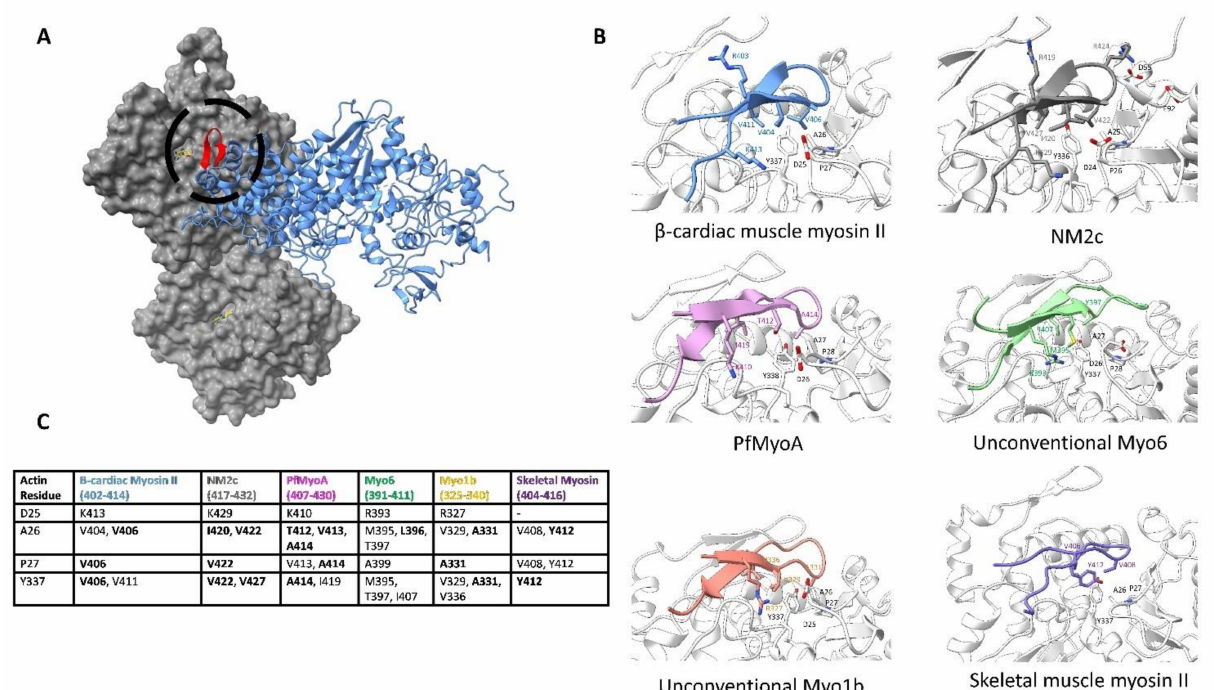
Figure 6. F-actin subdomain 1 binds to the CM loop. ( A ). The overall positioning of the actin surface relative to the CM loop. The motor domain is in blue while the CM loop is colored in red and circled; actin is in gray. ( B ). The residue-level binding interface between actin subdomain 1 and the myosin CM loop from the six myosin structures is indicated in Supplementary Item Table S2. Actin backbone and residues are colored white, while myosin residues are colored by isoform. Noted residues involved in binding are shown and labeled. In each isoform, the hydrophobic actin residues face at least three apolar myosin residues. Additional electrostatic interactions at the base of the loop play a further role in binding. ( C ). Residue-to-residue contacts determined for the cryo-EM structures indicated in Supplementary Item Table S2. All residues on myosin that come within 5 Å of the indicated actin residue are listed with residues coming within 4 Å appearing in bold. The actin sequence is based on the Chicken ACTA1 numbering (UniProt: P68139). The extent of the hydrophobic surface between subdomain 1 and the CM loop is clear when looking at the contacts of individual